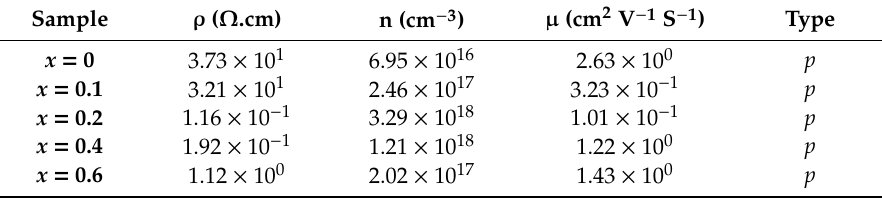
Table 3. Electrical properties of the Cu 2 Mg x Zn 1 − x SnS 4 (0 ≤ x ≤ 0.6) thin